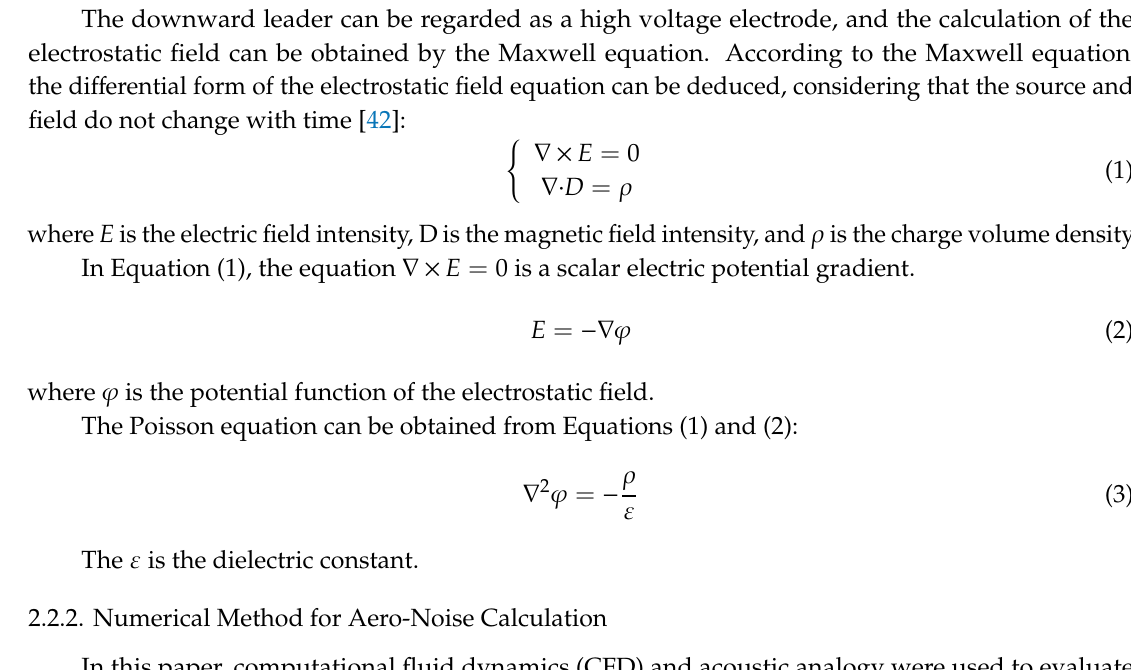
Figure 4. Experimental device.